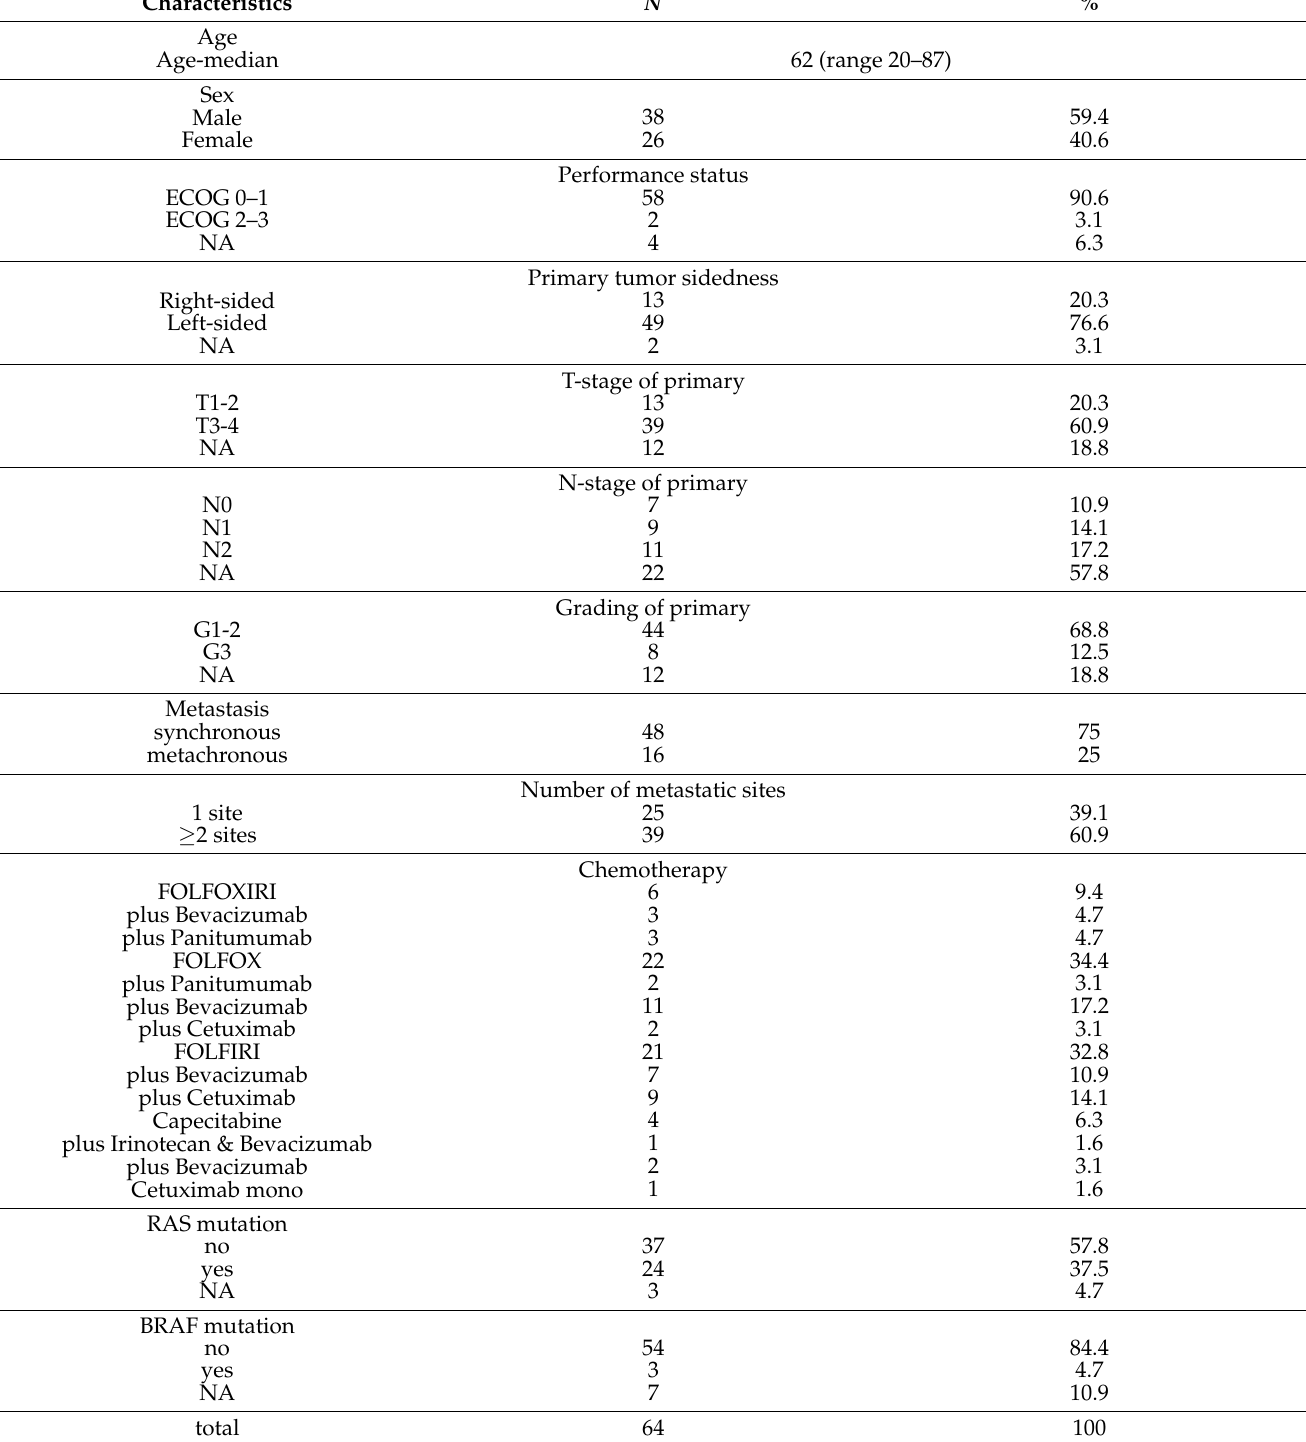
Table 1. Patient and tumor baseline